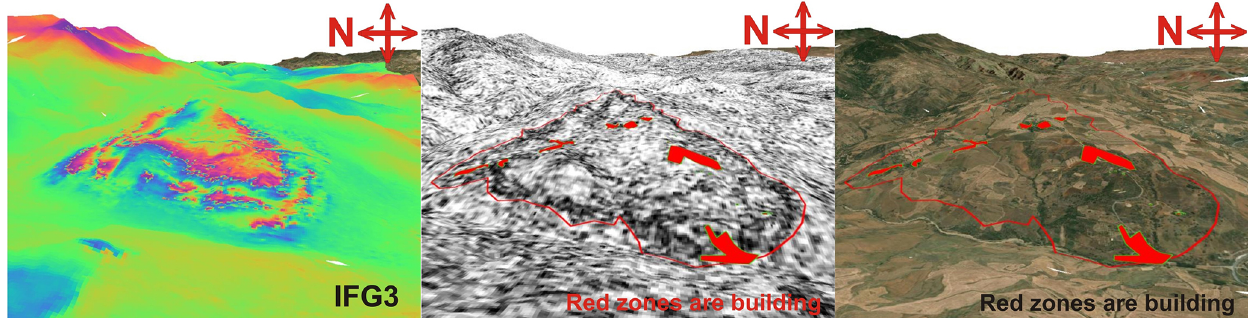
Figure 9. The 3D view of Grarem area, images of IFG-3. Each fringe is the wavelength divided by 2 in LOS, and red zones represent existing building compounds (QGIS, ESRI basemap).